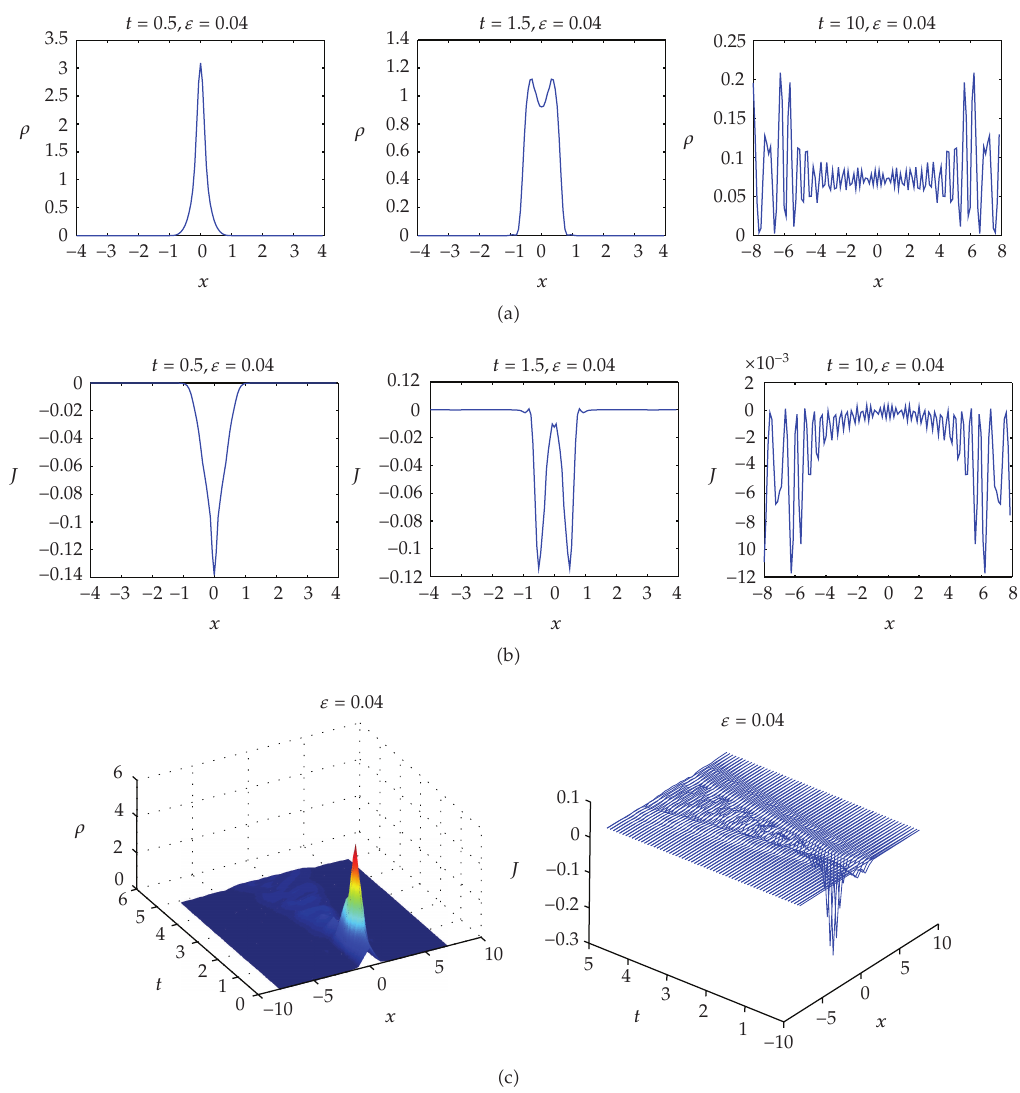
Figure 2: Numerical solutions of Example 5.1 by ED2/EP2 for the weak O (cid:3) ε (cid:4) defocusing nonlinearity (cid:3) ε (cid:6) 0 . 04 (cid:4) . (cid:3) a (cid:4) Position density ρ at t (cid:6) 0 . 5 (cid:3) before breaking (cid:4) , at t (cid:6) 1 . 5 (cid:3) after breaking (cid:4) , at t (cid:6) 10. (cid:3) b (cid:4) Current density J at t (cid:6) 0 . 5 (cid:3) before breaking (cid:4) , at t (cid:6) 1 . 5 (cid:3) after breaking (cid:4) , at t (cid:6) 10. (cid:3) c (cid:4) Evolution of the position density ρ (cid:3) left (cid:4) and the current density J (cid:3) right (cid:4)